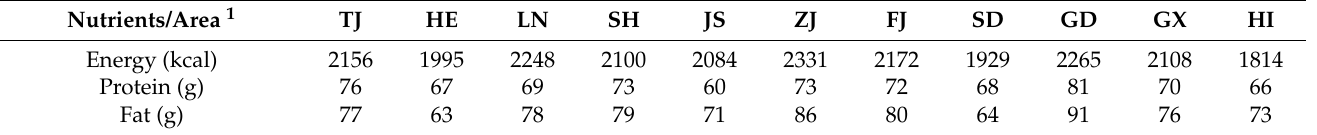
Table 2. The daily food nutrient consumption per person in coastal areas of China.